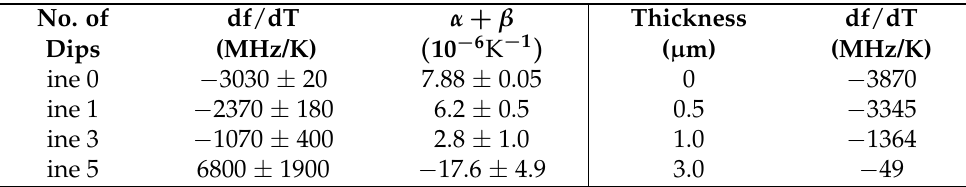
Table 2. (left panel) The measured temperature-dependent resonance shifts and the sums of α and β coefficients for PMMA-coated microspheres in air. (right panel) Modeling results for the 0, 0.5, 1.0, and 3.0 µ m thick PMMA coatings on 550 µ m silica